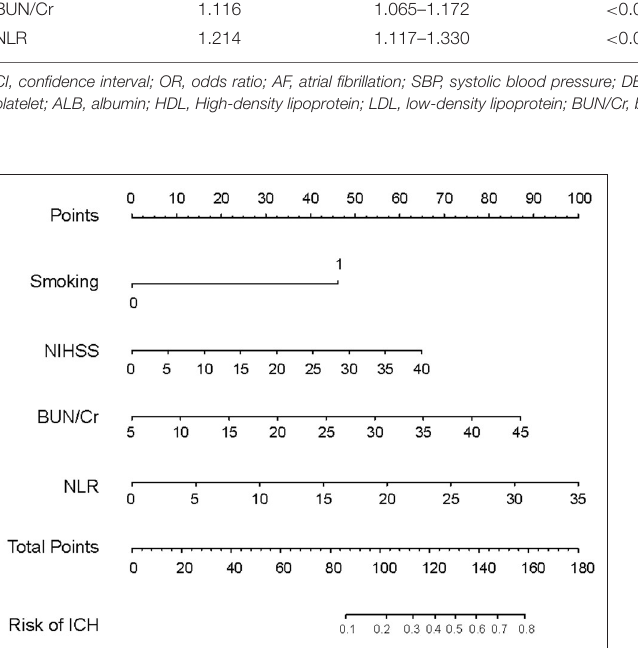
FIGURE 3 | Nomogram model for predicting individual risk of intracranial hemorrhage in AIS patients with intravenous thrombolysis. For all patients, adding up the points identified on the points scale for all four indicators. Then, the sum is located on the “Total Points” axis. Finally, the risk of ICH according to the nomogram is the probability of “ICH” corresponding to “Total Points”. NHISS, National Institute Health of Stroke Scale; BUN/Cr, blood urea nitrogen-to-creatinine ratio; NLR, neutrophil-to-lymphocyte